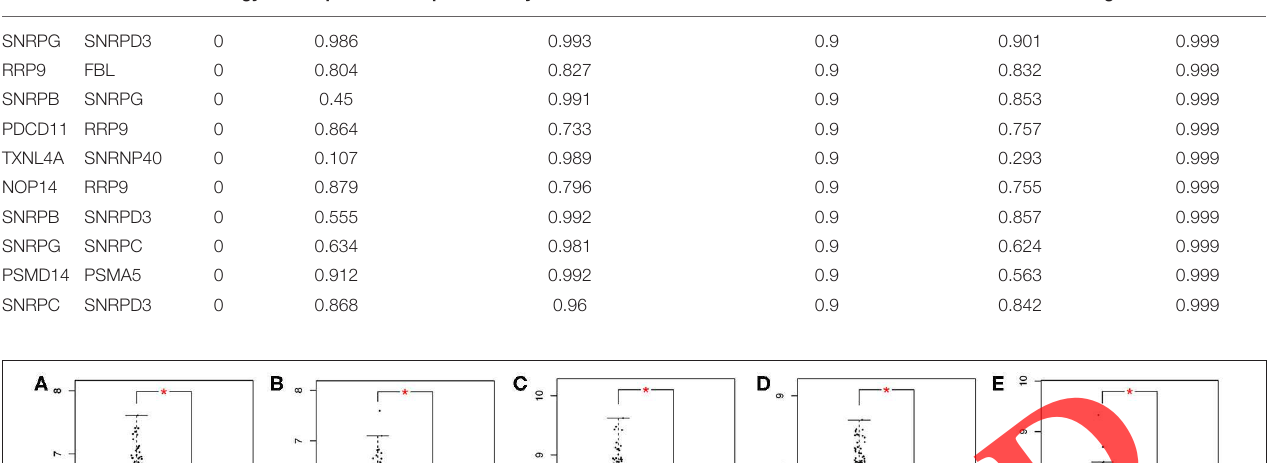
TABLE 2 | Top 10 pairs of hub genes from the PPI network. Node-1 Node-2